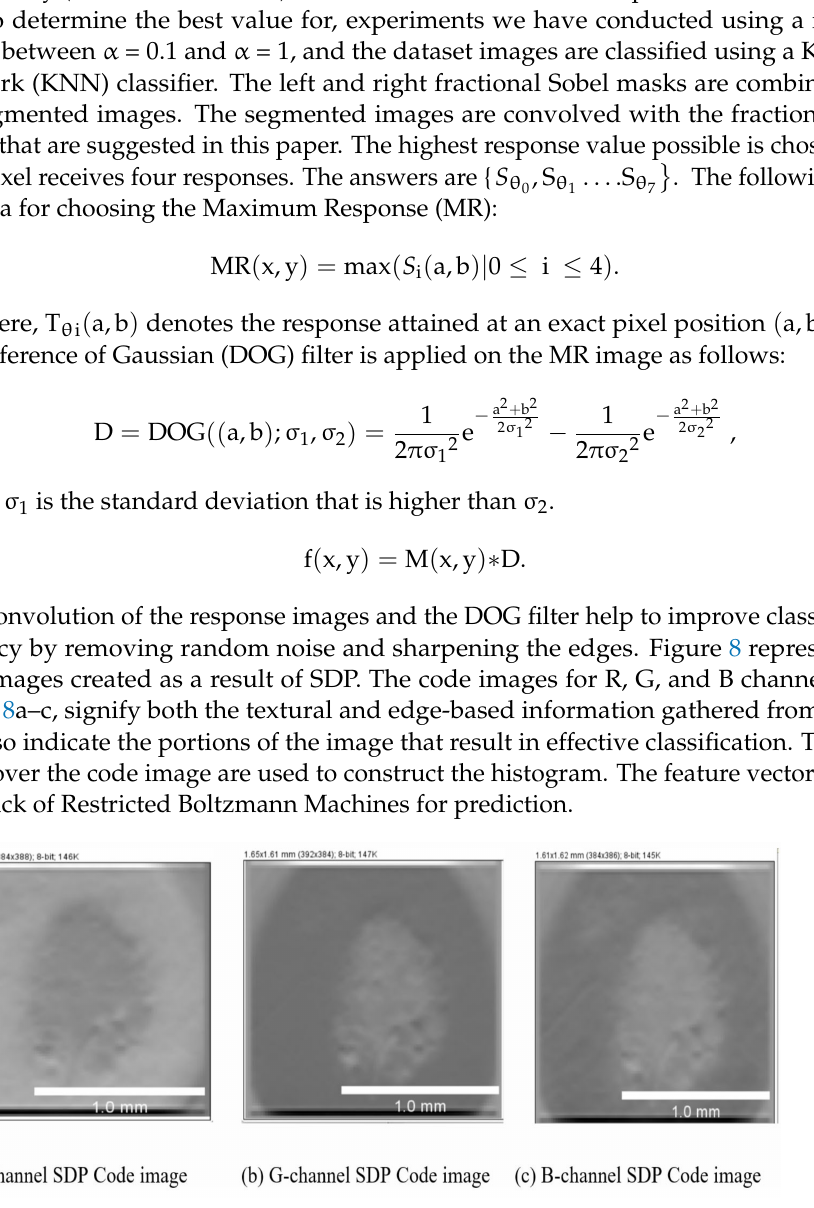
Figure 8. Sobel code images of the PH2 dataset; the size of the images are 238.2